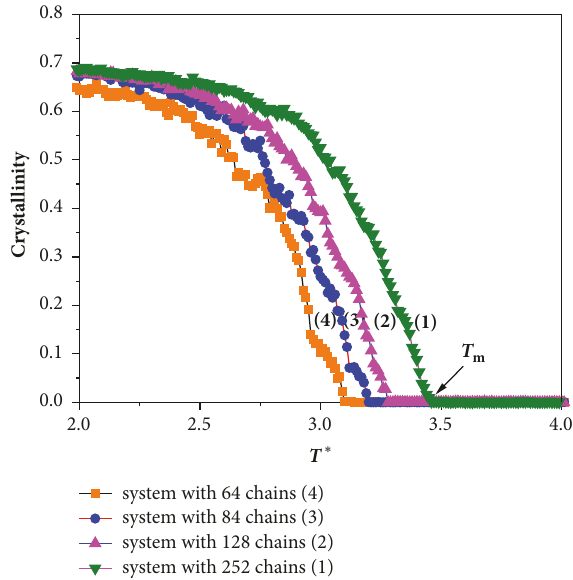
Figure 7: Evolutions of crystallinity for the grafted polymer systems with 64, 84, 128, and 252 polymer chains during heating processes,